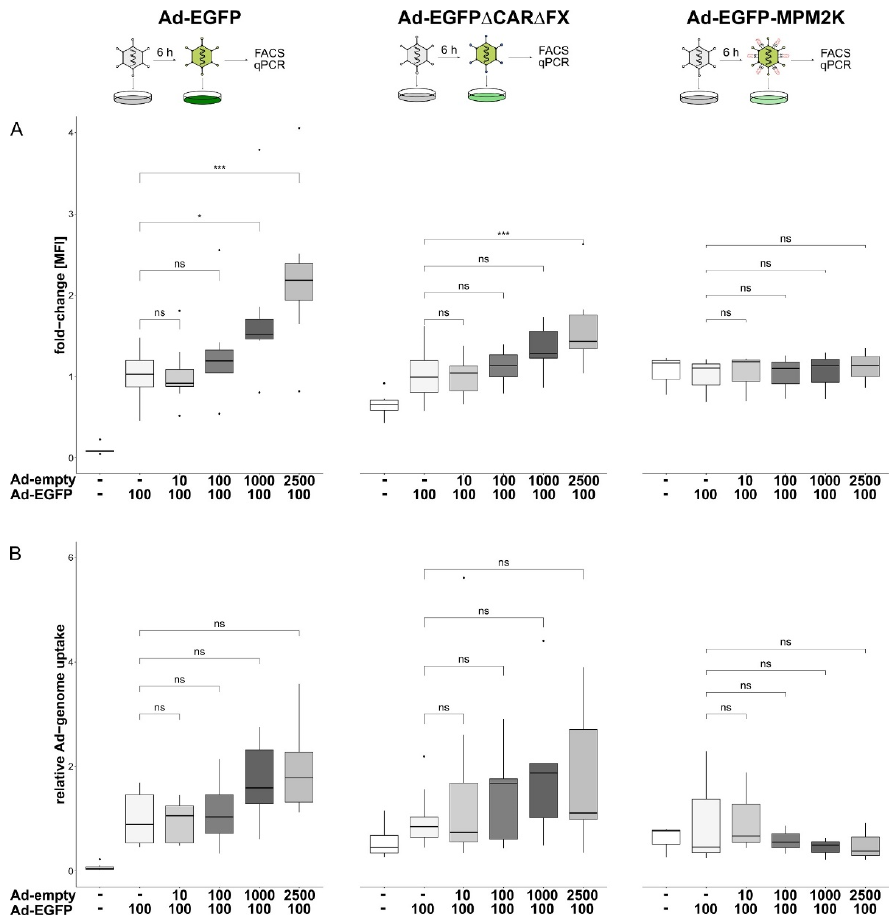
Figure 4. Effects of Ad-vector pre-treatment on vector particle uptake and cellular trafficking. Cells were transduced (pre-treated) with escalating doses of Ad-empty followed by transduction with EGFP-expressing vectors harbouring different capsid-modifications (left panel, wt capsid; center, ablated binding of CAR and FX; right panel, irreversible coupling to bi-functional PEG MPM2K). ( A ) 24 hpt transgene expression was analysed in flow cytometry. Increasing doses of Ad-empty resulted in increased transgene expression of Ad-EGFP (2.22 ± 0.91-fold, p < 0.001) and Ad- EGFP ∆ CAR ∆ FX (1.56 ± 0.48-fold, p < 0.001). However, transgene expression was not detected for Ad-EGFP-MPM2K (1.11 ± 0.24-fold, p = 0.634). ( B ) Genomic DNA at 24 hpt was extracted and EGFP- containing vector genomes were quantified. Again, escalating doses of Ad-empty correlated with an increased number of EGFP-containing vector genomes per cell for Ad-EGFP (1.99 ± 0.92-fold, p = 0.056) and Ad-EGFP ∆ CAR ∆ FX (2.24 ± 1.95-fold, p = 0.083), although this was not statistically signif- icant. However, genome copies of Ad-EGFP-MPM2K could not be detected (0.5 ± 0.36-fold, p = 0.98). Significance values were calculated with Dunnett’s test. MOIs (multiplicity of infection) were ap- plied as indicated. MFI, mean fluorescence intensity; ns, p > 0.05; *, p < 0.05; ***, p < 0.001. These results indicate that transduction efficiencies did not solely depend on the MOI applied. Rather, the overall quantity of the applied vector particles synergistically in- creased transduction efficiencies, presumably by promoting the uptake of viral particles. A similar synergistic effect was also observed when the cells were transduced simultane- ously with Ad-tdTomato (MOI 100) and escalating doses of Ad-empty (MOI 1000: 1.94 ± 0.25-fold, p = 0.021; Figure 5A). A comparable pattern occurred when Ad-tdTomato ge- nomes were quantified; genome copies increased with increasing doses of Ad-empty, alt- hough this was not statistically significant (2.69 ± 1.1-fold, p = 0.09; Figure 5B). Therefore,